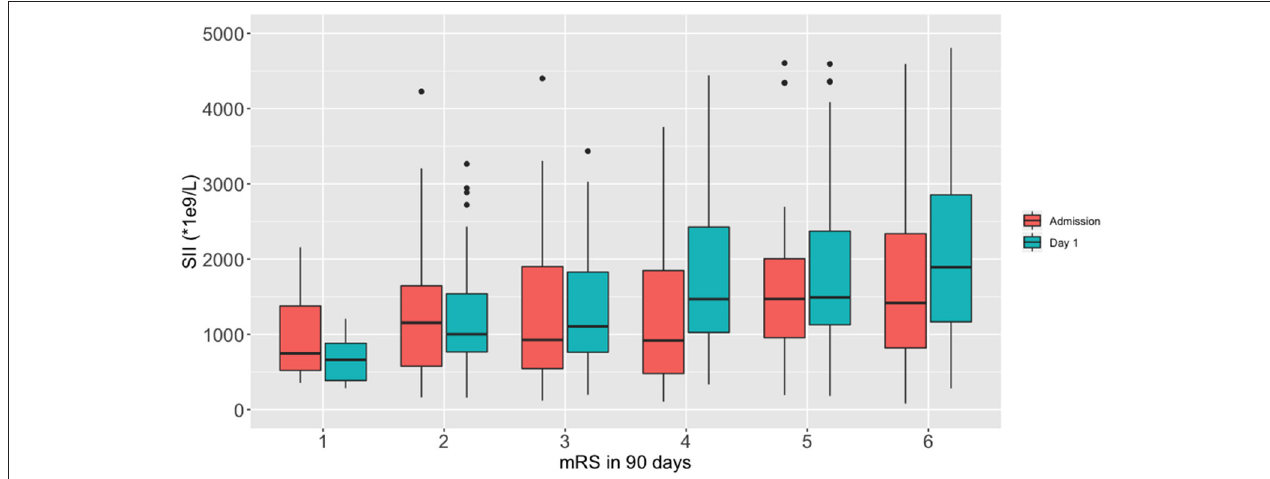
FIGURE 2 | Boxplots of admission and day-1 SII stratified by ordinal